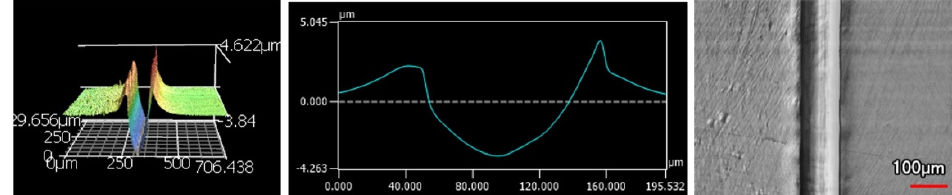
Figure 14. 9 μ m Thick Ni-P-NiTi Coating 100 Passes of the Sharp Indenter.